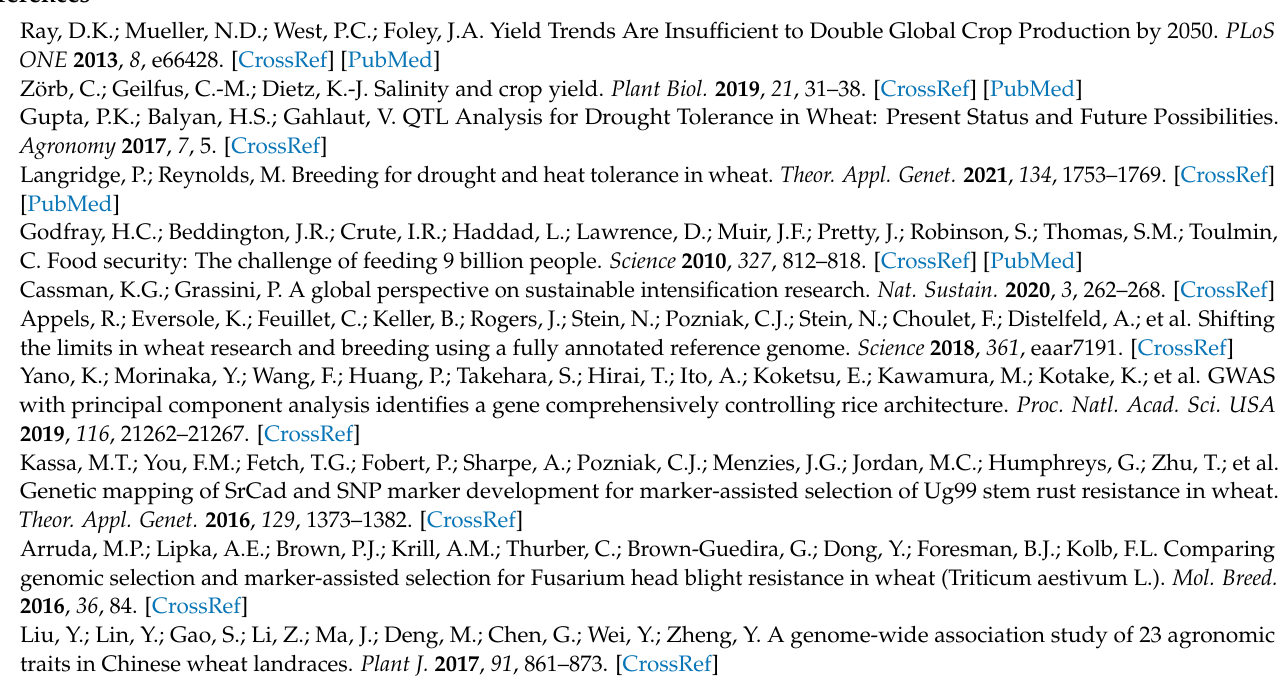
Table S7: The list of gene numbers and gene IDs on the 20 QTLs loci associated with abiotic stress responses in